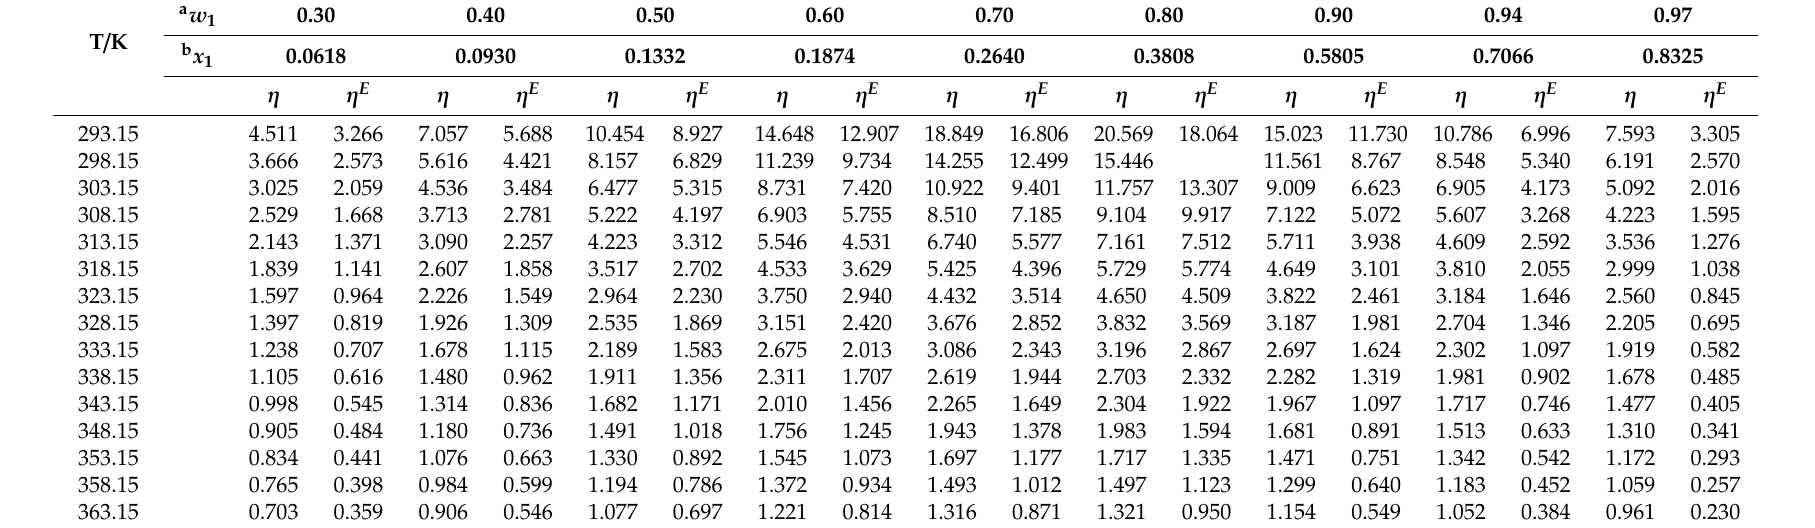
Table A7. Measured viscosity ( η / mPa · s) and deduced viscosity deviation ( η E / mPa · s) of DEEA (1) + H 2 O (2)